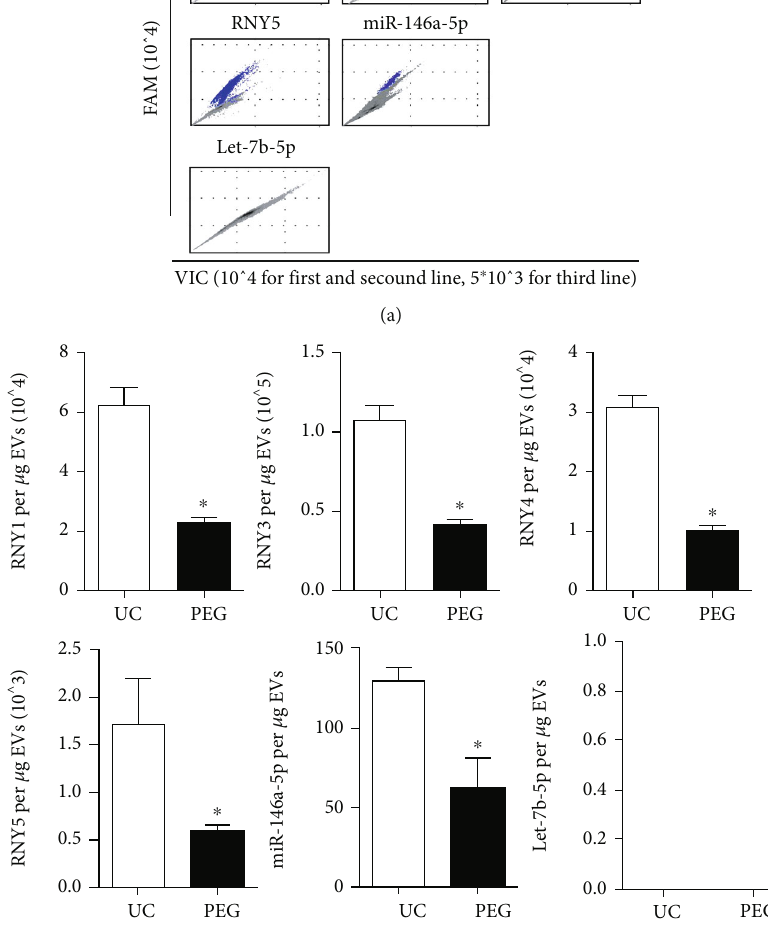
Figure 2: Comparison of RNA expression of UC-EVs and PEG-EVs. (a) The copy numbers of RNY1, RNY3, RNY4, RNY5, miR-146a-5p, and Let-7b-5p detected in EVs by droplet digital PCR; blue points indicate positive reads, and gray points indicate negative reads. (b) the statistical analysis of RNA expression ( n = 3 ). The concrete level of each RNA marker was statistically analyzed by the positive copy number reads of droplet digital PCR and its loading quantity. The RNA level of each gene was di ff erent by an order of magnitude; the most highly expressed was RNY3, and no Let-7b-5p signal was detected. There was a signi fi cant increase in the detected RNA of UC- derived EVs compared with PEG, ∗ for P < 0 : 05